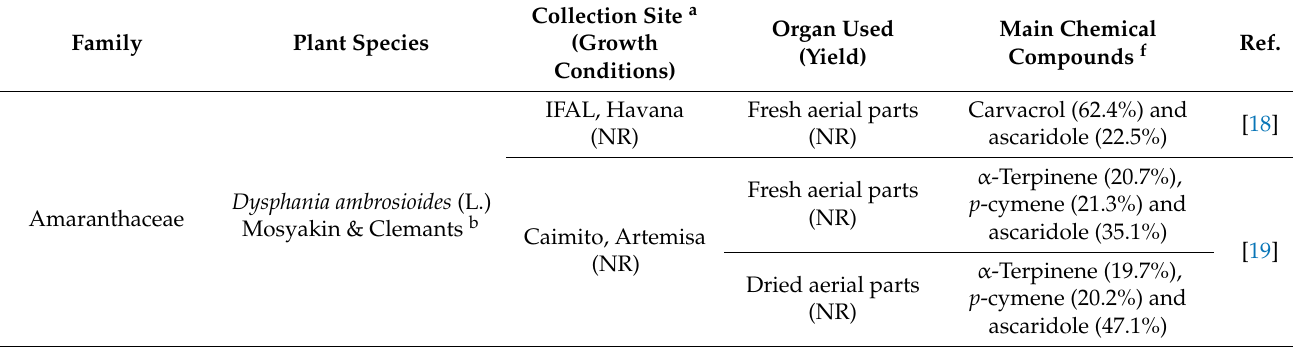
Table 2. Main characteristics of Cuban plants investigated in publications included in this review. Collection Site Family Plant Species